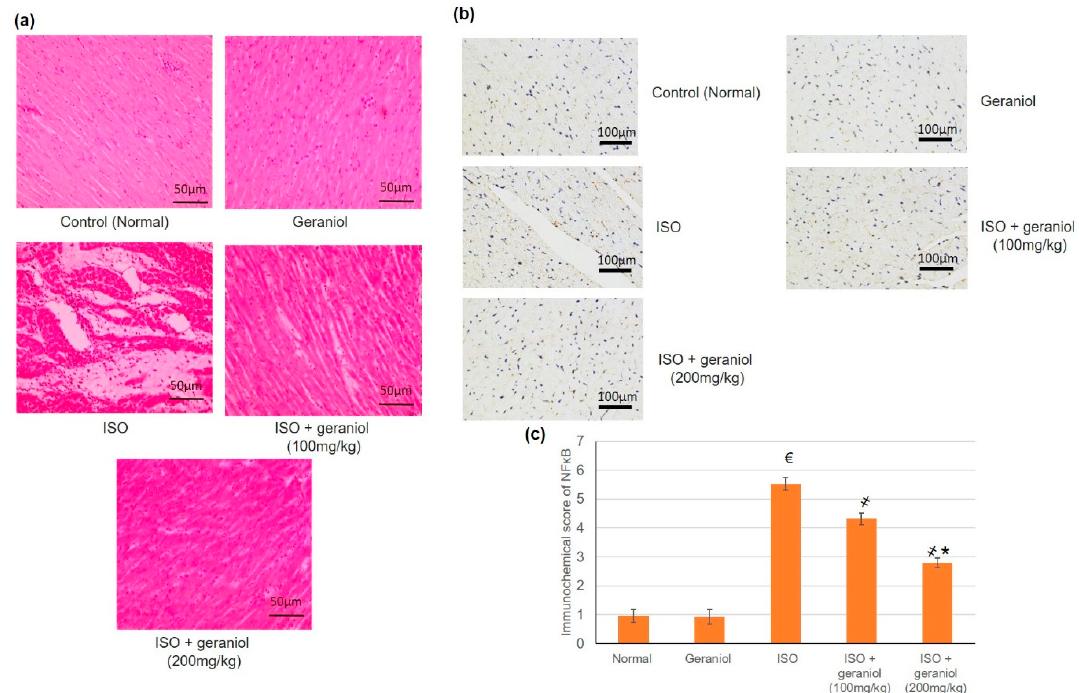
Figure 8. Histopathological investigation ( a ), immunohistochemical assay ( b , c ) immunohistochemical scoring of geraniol (100 or 200 mg / kg)-pretreated rats subjected to isoproterenol (ISO)-induced myocardial infraction (MI). Histopathological analysis was performed using hematoxylin and eosin (H&E) staining of the myocardial tissue sections; immunohistochemical staining of cardiac tissues was performed with antibody recognizing NF- κ B. All values were stated as mean ± SD ( n = 6). € , p < 0.05 compared to the normal group; ҂ , p < 0.05 compared to the ISO-induced MI group; *, p < 0.05 compared to the ISO + geraniol (100 mg/kg) group. Comparisons done using one-way ANOVA followed by Tukey-Kramer post-hoc test.